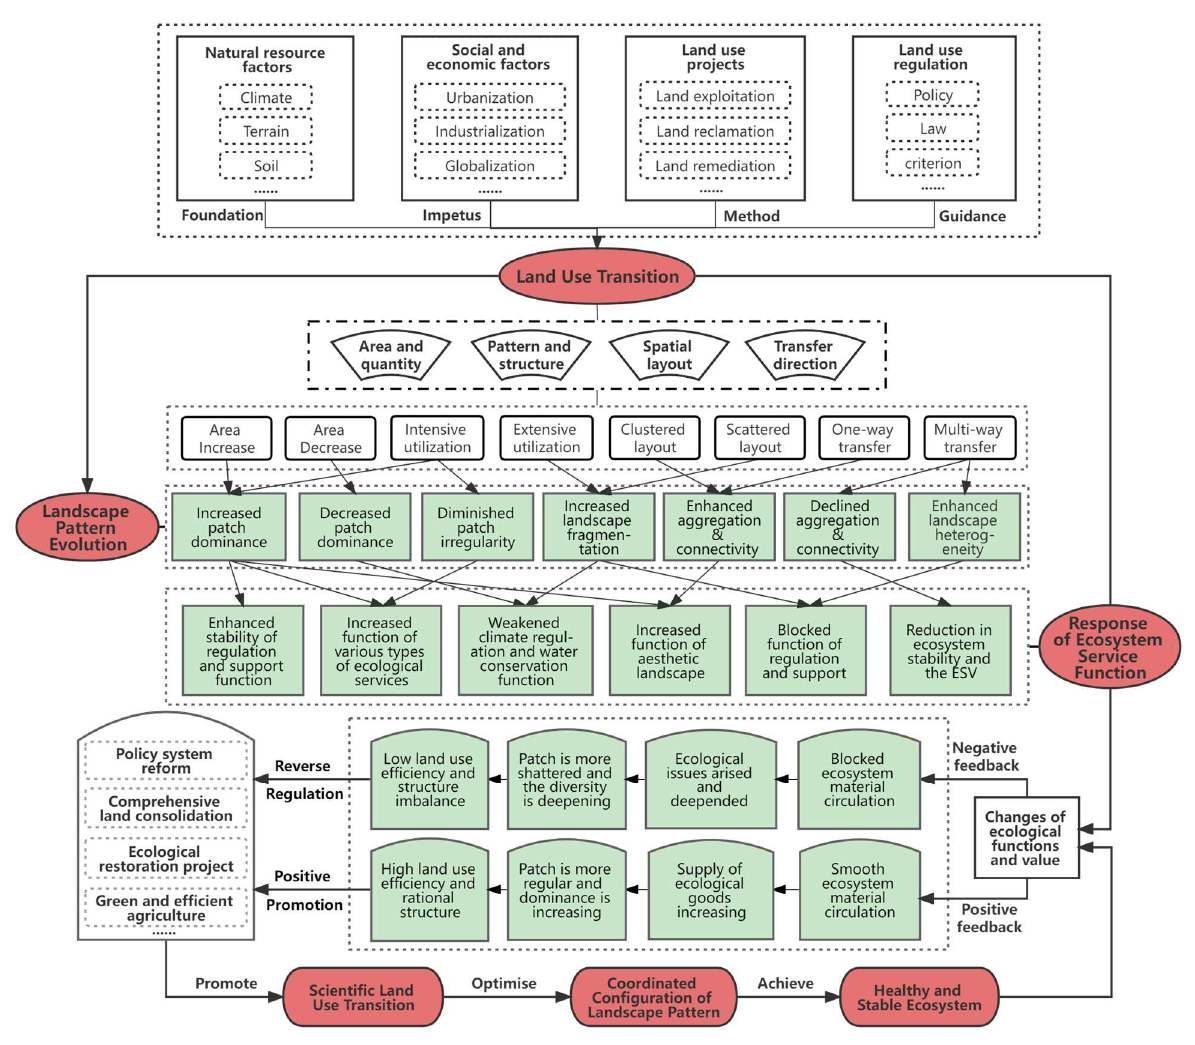
Figure 2. Theoretical analysis framework of land use transition, landscape pattern evolution and ecosystem service function responses.